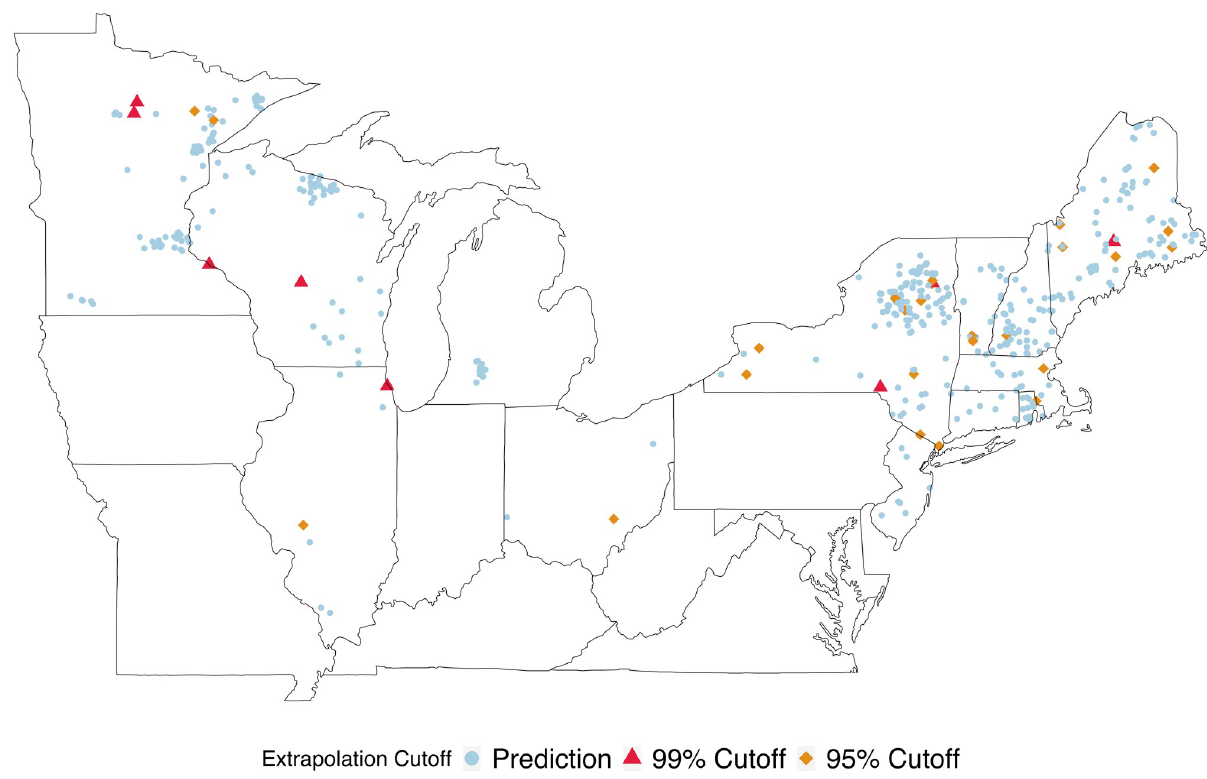
Fig 3. Identification of prediction vs extrapolation locations of LAGOS-NE lakes. Four cutoff approaches are compared and presented. Lakes in orange diamonds and red triangles indicate those where predictions were beyond the 99% and 95% cutoff values, respectively, and thus considered extrapolations. The color and shape of extrapolated lake locations are determined by which cutoff value first identifies the prediction at that location as an extrapolation.